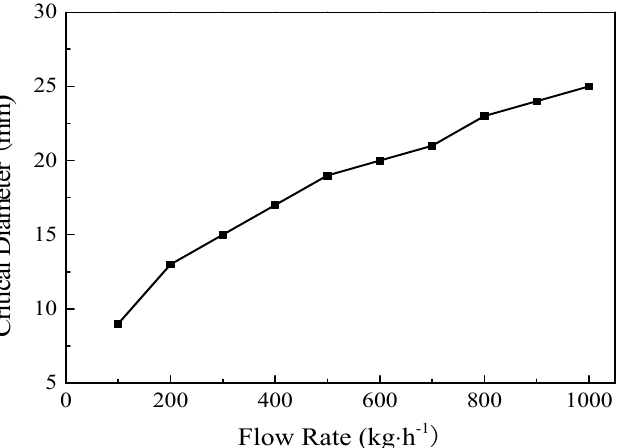
Figure 5. The critical diameter of the reactor at different flow rates of Chlorella (300 ° C, 20 MPa, and 80 wt% moisture content).